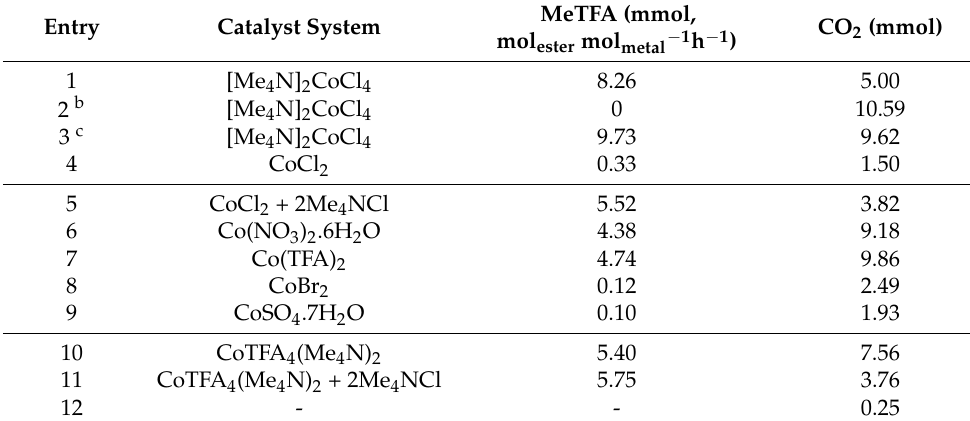
Table 1. Aerobic methane oxidation using various Co catalysts a .